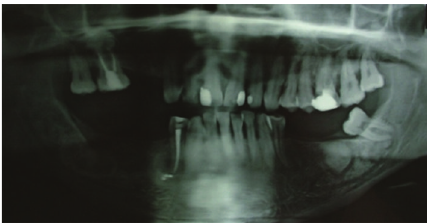
Figure 6: The follow-up after one year of both tumors was negative for disease